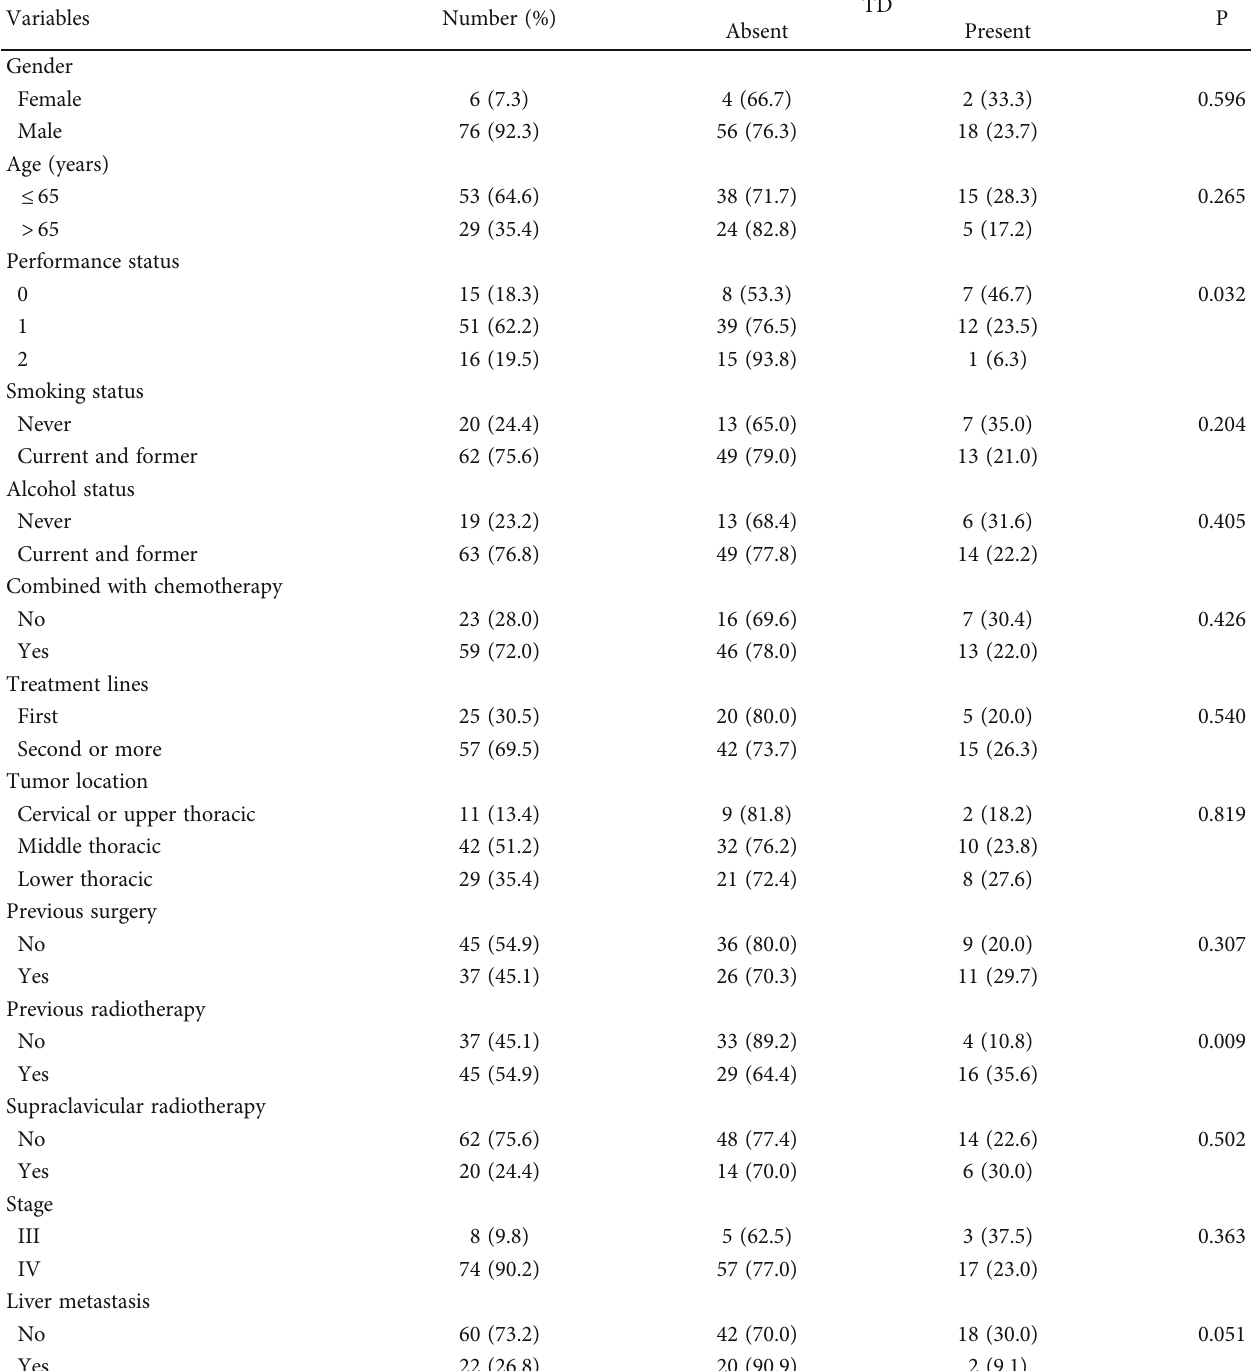
Table 1: Correlations between the occurrence of TD and clinicopathological